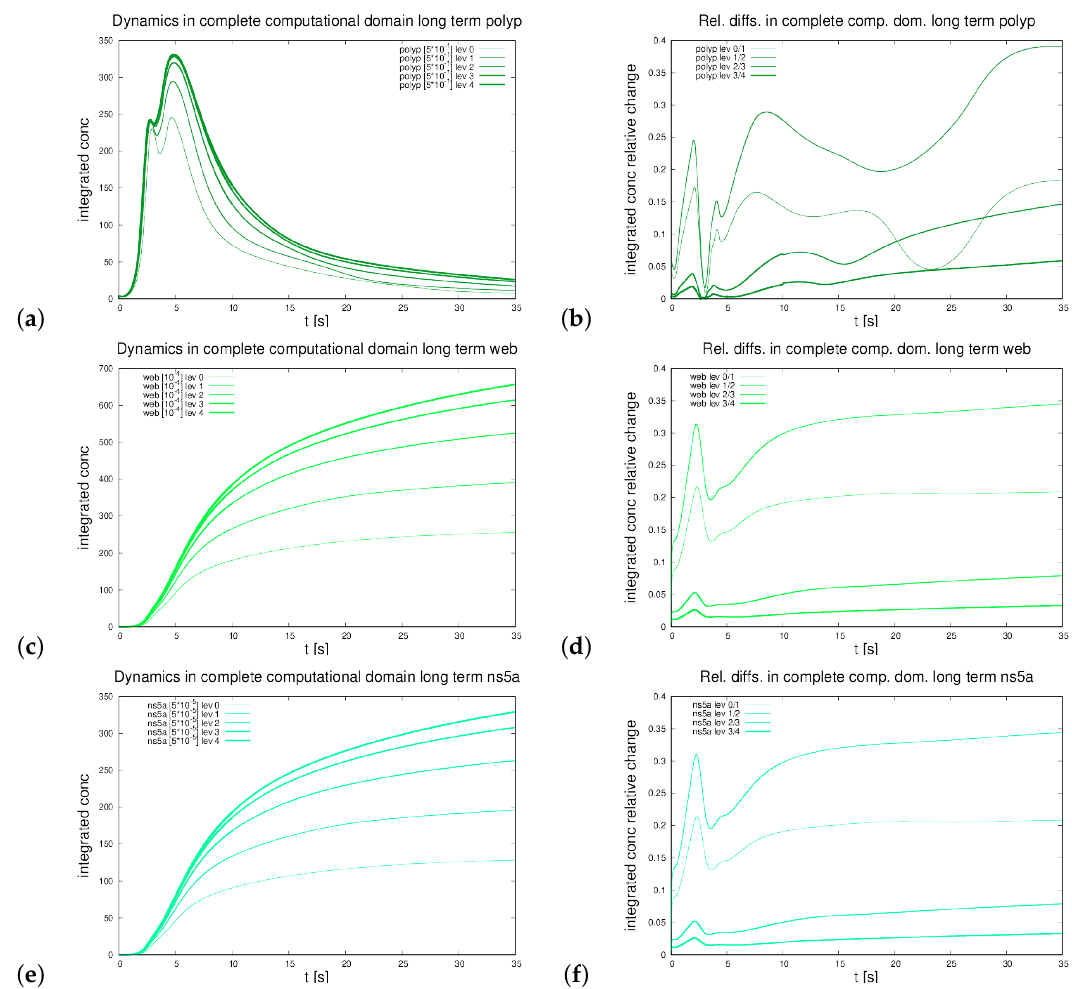
Figure A1. Development of integrated concentrations within complete computational domain under spatial refinement from level 0 (base level, direct reconstructed geometry) up to level 4 and relative differences respectively for concentrations of viral proteins. From top to down: Polyprotein, web protein, and NS5a. Left shows absolute values, while right shows relative differences. In detail: ( a ) Polyprotein absolute values for different grid refinement levevls, ( b ) Polyprotein relative differences for different grid refinement levels, ( c ) web protein absolute values, ( d ) web protein relative differences, ( e ) NS5a absolute values, ( f ) NS5a relative